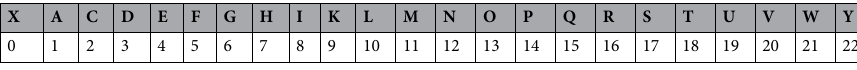
Table 1. Amino acid encodings for feature